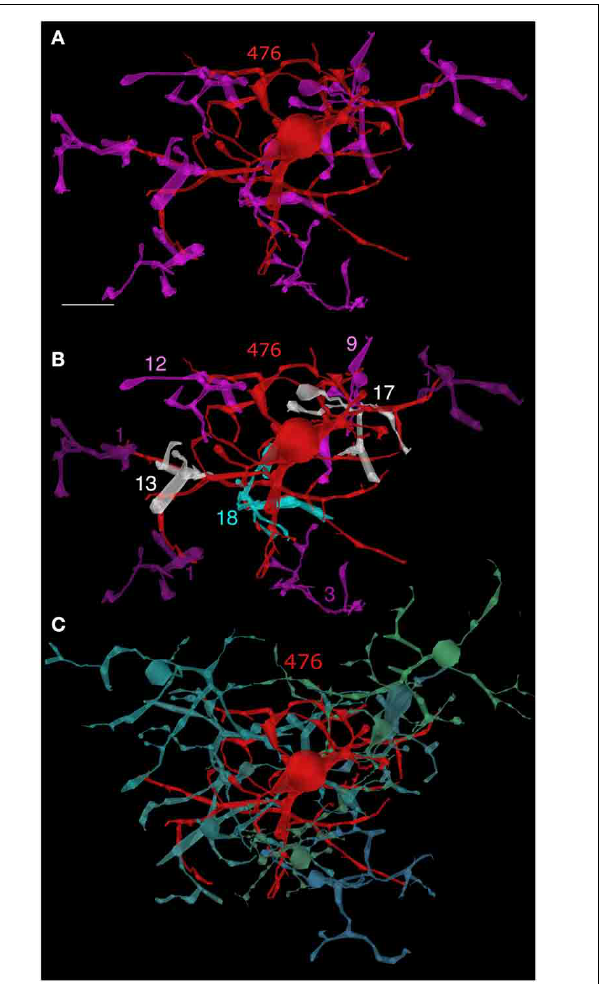
contacting nine rod bipolar cells (magenta). (B) Contact weights: 1 ribbon (dark purple), 3 ribbons (purple), 9–12 ribbons (magenta), 13–17 ribbons (white), 18 ribbons (cyan). (C) AII cell 476—ON cone bipolar cell clusters. Eight ON cone bipolar cells representing five of the eight known classes make multiple gap junctions with AII 476. Scale, 10 μ m.